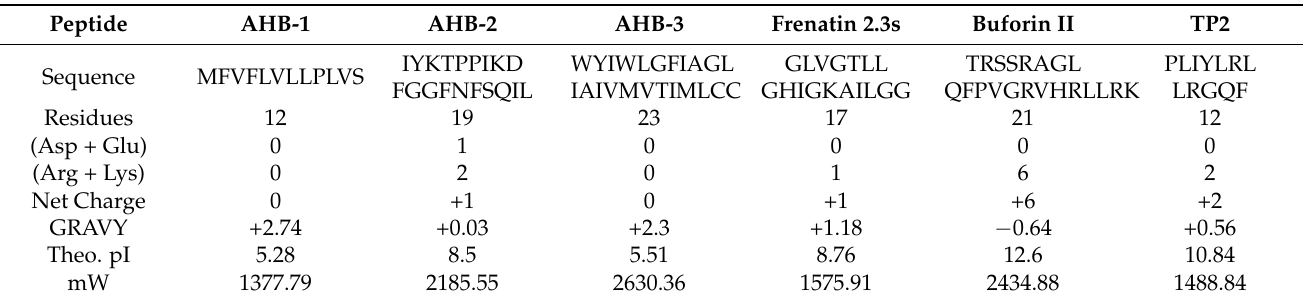
Table 1. Primary sequence and physicochemical properties of evaluated peptides (AHB-1, AHB-2, and AHB-3) extracted from the ProtParam tool by ExPASy [58] and comparison with reference peptides (Frenatin 2.3s, Buforin II, and